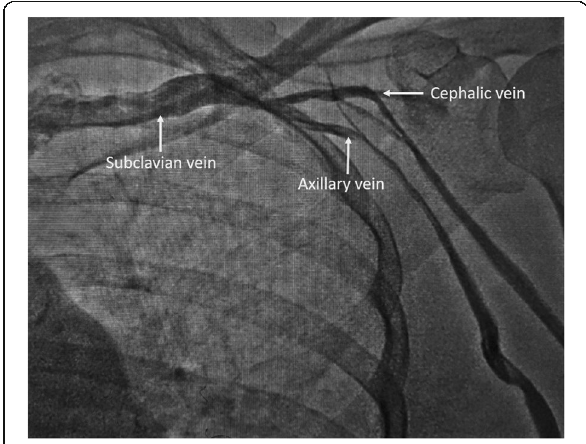
Fig. 1 Intravenous contrast injection from the left brachial vein showing good-sized axillary and subclavian veins